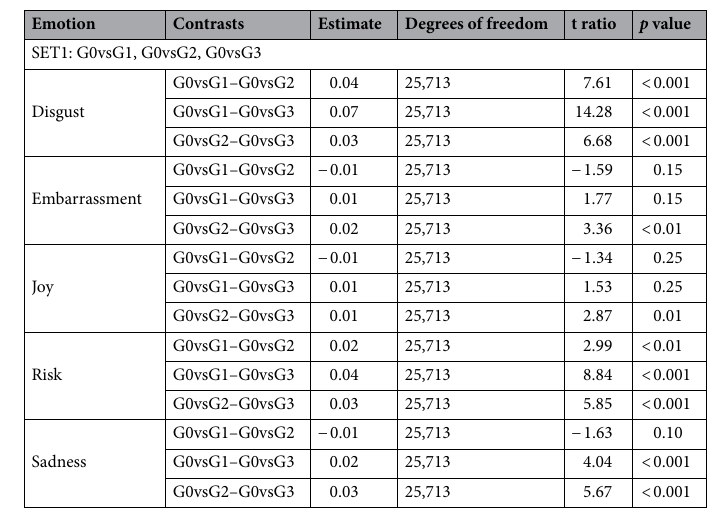
Table 1. Summary of follow-up tests statistics for cosine similarity (CS) mean differences between emotions and within generation contrasts from SET1.